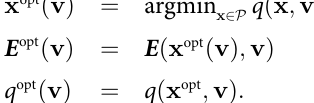
Fig 7. The conversion between fluxes and enzyme levels, in both directions. (a) Starting from the logarithmic enzyme level (dashedline on top), we add the terms log k þ better and better approximation of the rate. In the example shown, k þ The more precise approximations (with more terms) yield smaller rates. The EMC4 arrows refer to other possiblerate laws with additional terms in the denominator.(b) Enzyme demandis shaped by the same factors (see Eq (5)). Starting from a desired flux (bottom line), the predicted demandincreases as more terms are